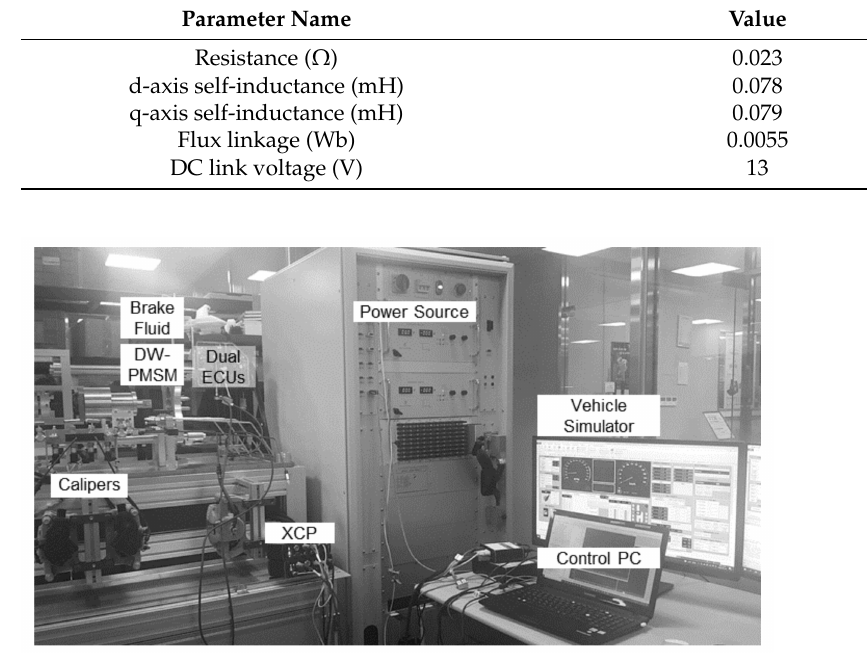
Figure 10. Photo of test